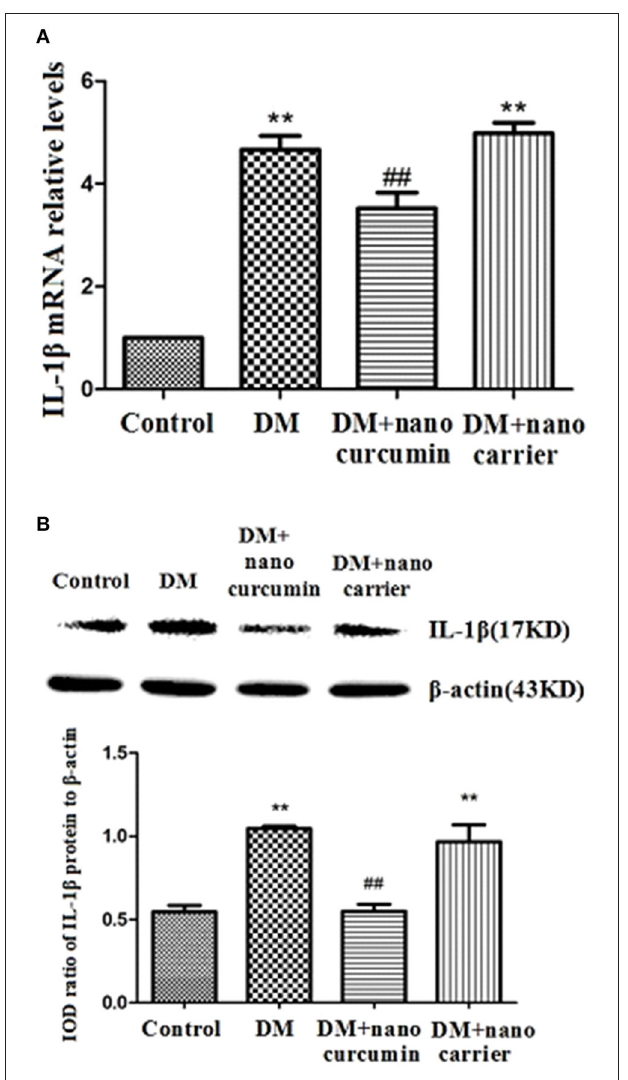
FIGURE 6 | Effects of nanoparticle-encapsulated curcumin on the expression of the Cx43 mRNA and protein in the DRG of the DM rats. (A) The expression of the Cx43 mRNA in the DRG was measured by RT-qPCR. Expression levels of the Cx43 mRNA were higher in the DM group than in the control group ( p < 0.01). In DM rats treated with nanoparticle-encapsulated curcumin, the levels of Cx43 mRNA expression were significantly decreased compared with those in the untreated DM rats ( p < 0.01). The experiment was performed three times ( n = 7 per group). Data are presented as means ± SEMs. ** p < 0.01 compared to the control group; ## p < 0.01 compared to the DM group. (B) The expression of the Cx43 protein in the DRG was measured by Western blotting. Expression levels of the Cx43 protein were higher in the DM group than those in the control group ( p < 0.01). In DM rats treated with nanoparticle-encapsulated curcumin, levels of the Cx43 protein were lower than those in the untreated DM group ( p < 0.01). No difference was observed between the DM + nanoparticle-encapsulated carrier group and the DM group ( p > 0.05). Bar graphs show the ratio of the Cx43 protein to the β -actin protein in each group. Data are displayed as means ± SEMs ( n = 7 per group). ** p < 0.01 compared to the control group; ## p < 0.01 compared to the DM